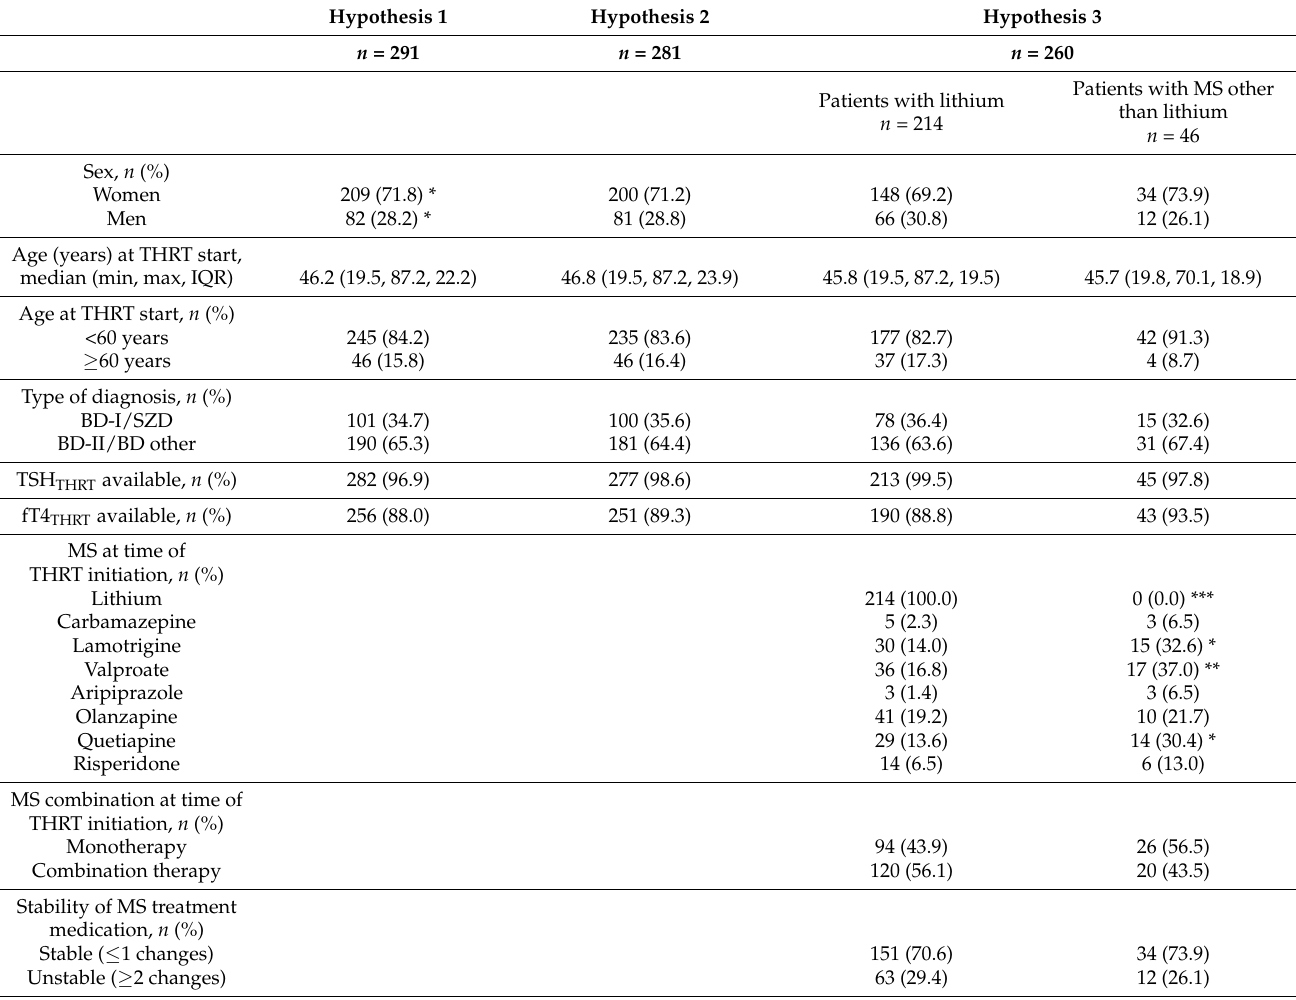
Table 2. Baseline